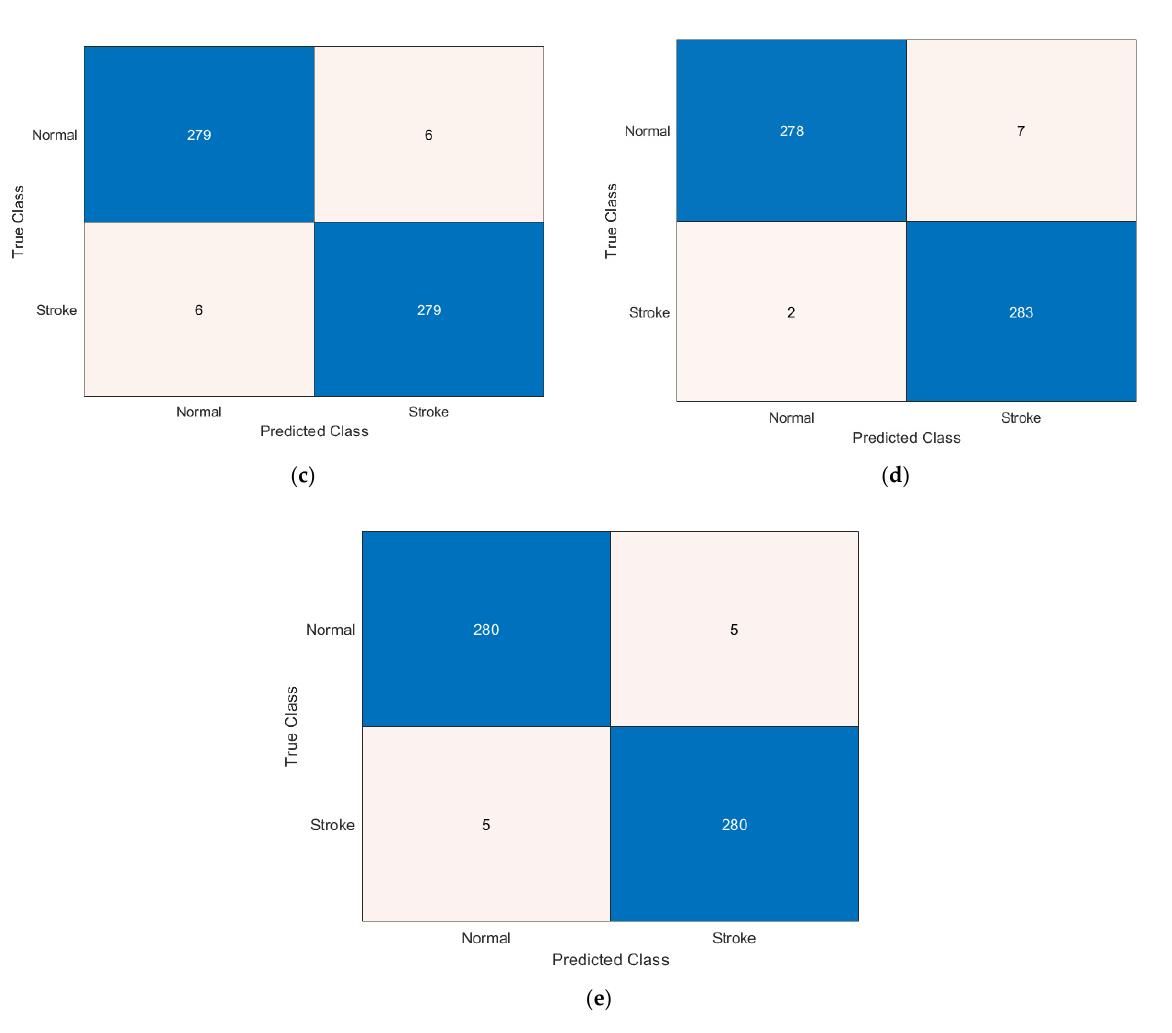
Figure 5. Performance metrics graph of different algorithms. 5. Discussion In this paper, we designed a novel structure for determining stroke from brain CT images. Essentially, this study has some advantages and disadvantages. First, we pre- sented advantages of the study as follows. (i) We designed a new deep learning algorithm,